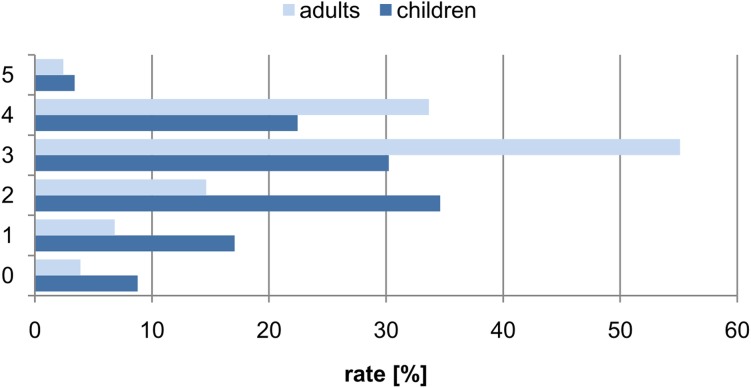
The percentage distribution of responses to the question of assessing one's own skills (on a scale of 0-"very poorly" to 5 = "very well") for the auscultation of adult and child respiratory systems.